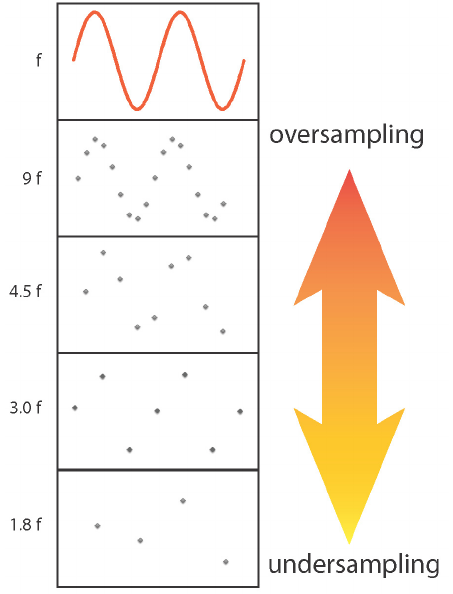
Figure 7. Effects of sampling rate on sampled data . A sinusoidal signal, f (top left), has been sampled at a number of different rates relative to its frequency. Progressively slower sampling reduces detail and signal quality. At frequencies above the Nyquist criterion of 2f, the frequency content of the signal can be seen (middle three traces). However, note that information has been lost in the bottom trace where the data have been sampled at 1.8f.